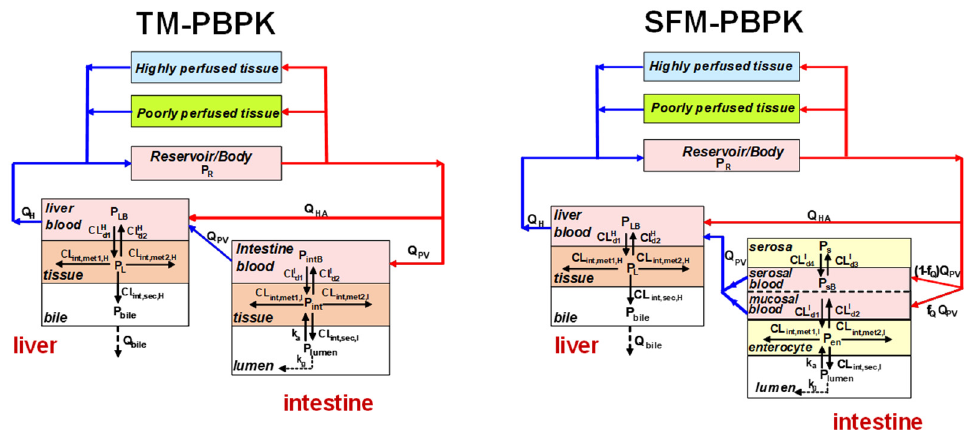
Figure 3. Physiologically based pharmacokinetic (PBPK) models depicting the intestine as a single tissue or compartment for the TM (left) or as the two subcompartments, the enterocyte and serosal subcompartments for the SFM (right), perfused by segregated flows. This figure was reproduced with permission from Sun and Pang [84], Springer, 2010.